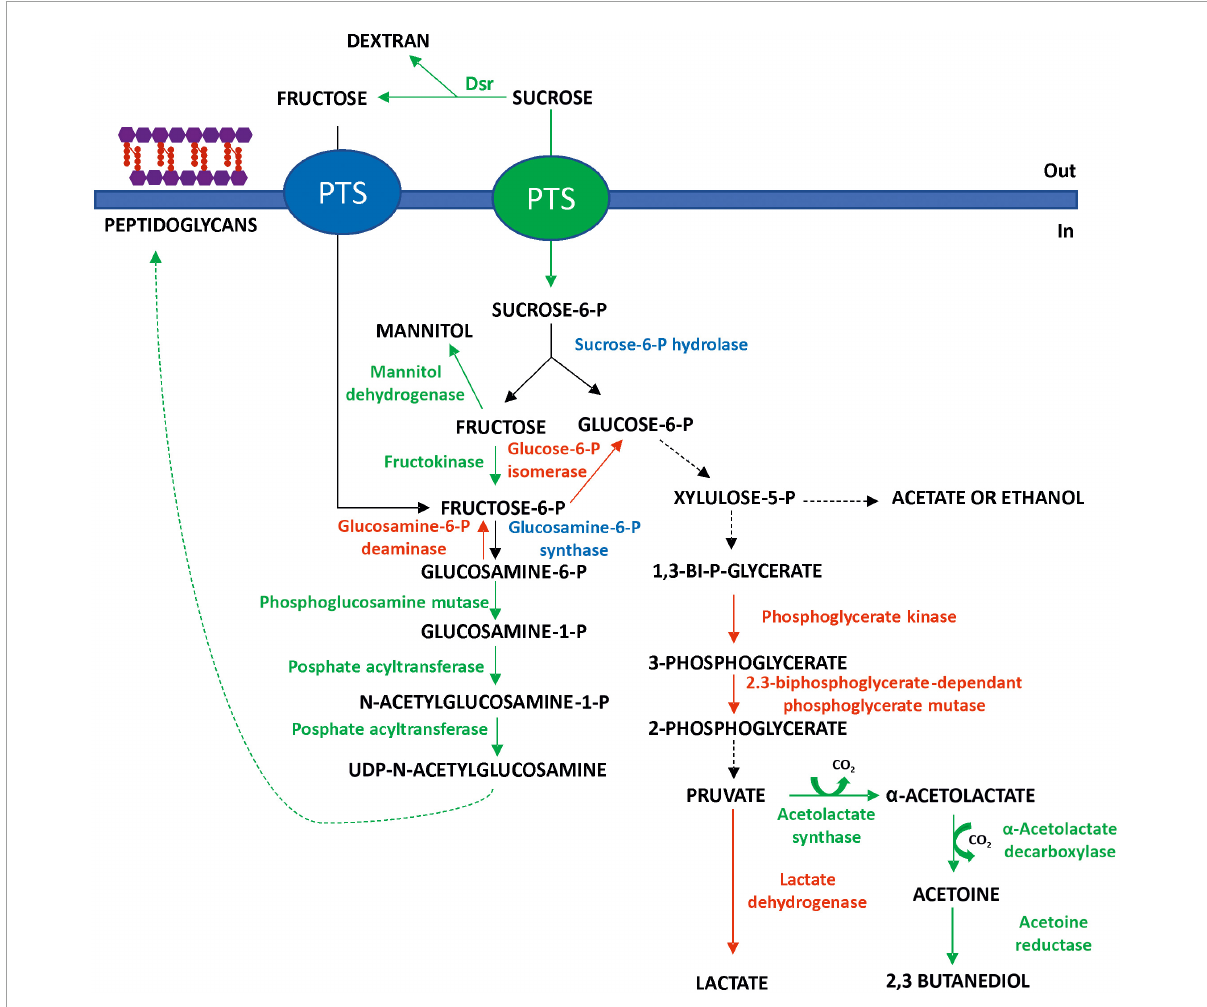
FIGURE8 Prediction of major carbohydrate utilization pathways in Lc. lactis AV1n at 20 ◦ C in the presence of sucrose as the sole carbon source, suggested by proteomic analysis. Red indicates the downregulated enzymes, green indicates the upregulated ones, and blue indicates non-differentially expressed